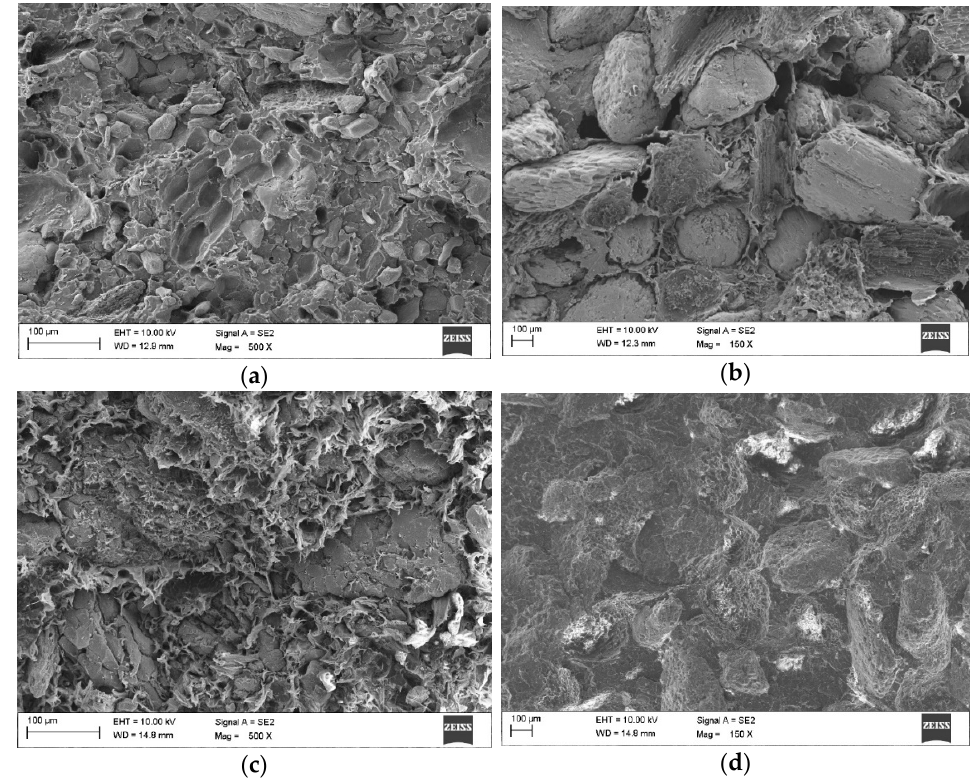
Figure 2. Photo of the produced PP/shell flour polymer composite material: ( a ) A4 and ( b ) C4 from hazelnuts and ( c ) D4 and ( d ) F4 from walnuts.